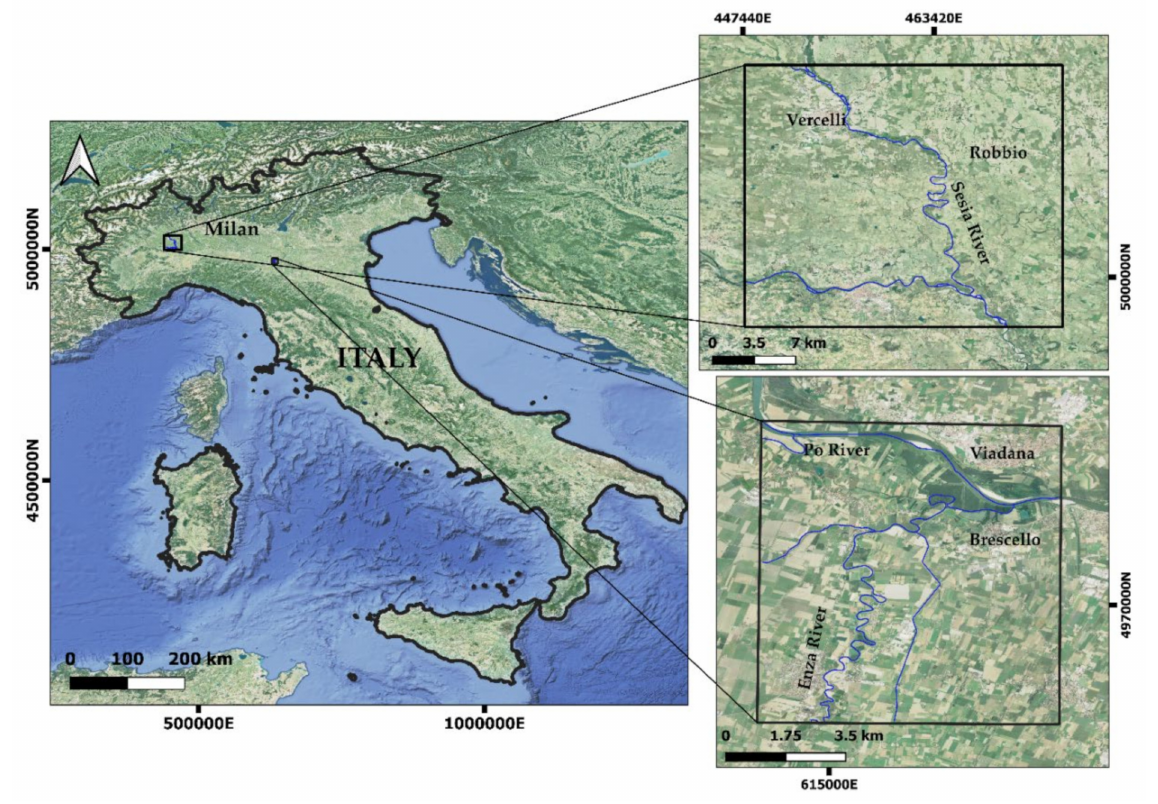
Figure 1. Location map of the two case studies in Italy. The lower and upper pictures show where the 2017 and 2020 events occurred, respectively. The blue lines represent rivers’ routes. The footprints of the image tiles, i.e., the borders of the regions of interest, are indicated by black solid squares. The background is Google satellite imagery, available in the QGIS